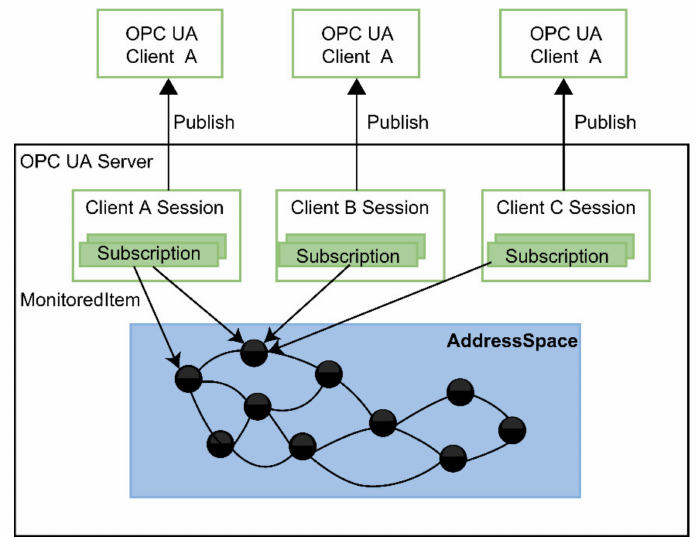
Figure 2. OPC UA PubSub communication model